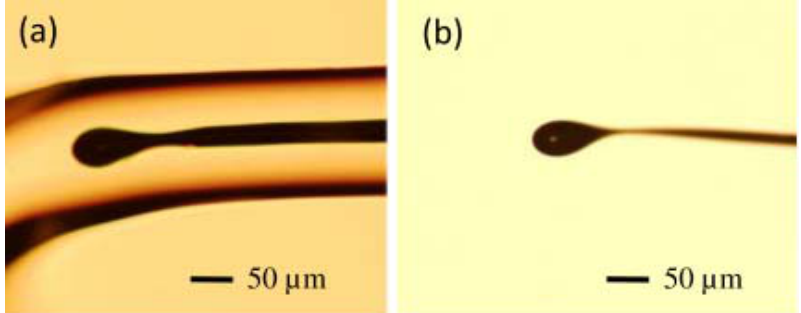
Figure 4. Microscope image of ( a ) a germanium microsphere in borosilicate cladding and ( b ) a fabricated germanium microsphere. Reprinted/Adapted with permission from [66].